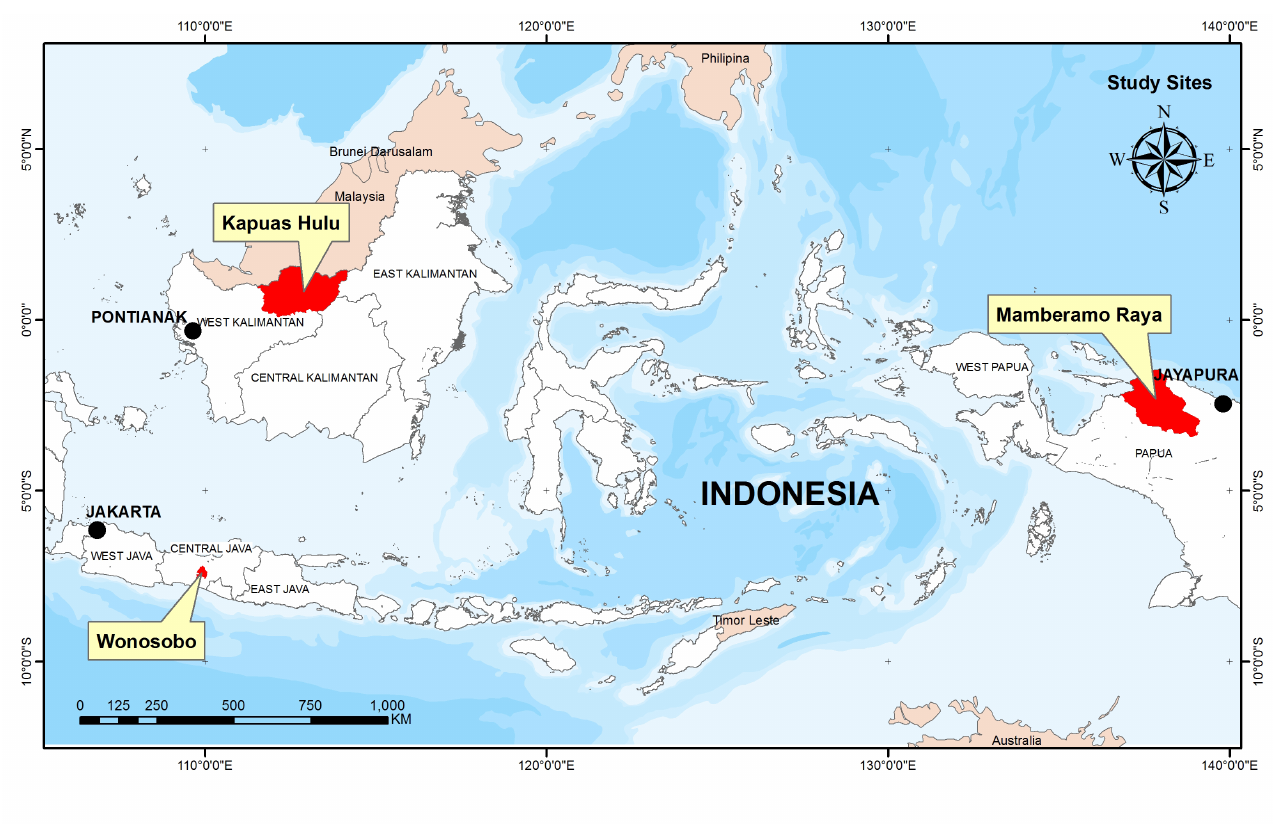
Figure 1. Map of the research sites in Papua, West Kalimantan, and Central Java.